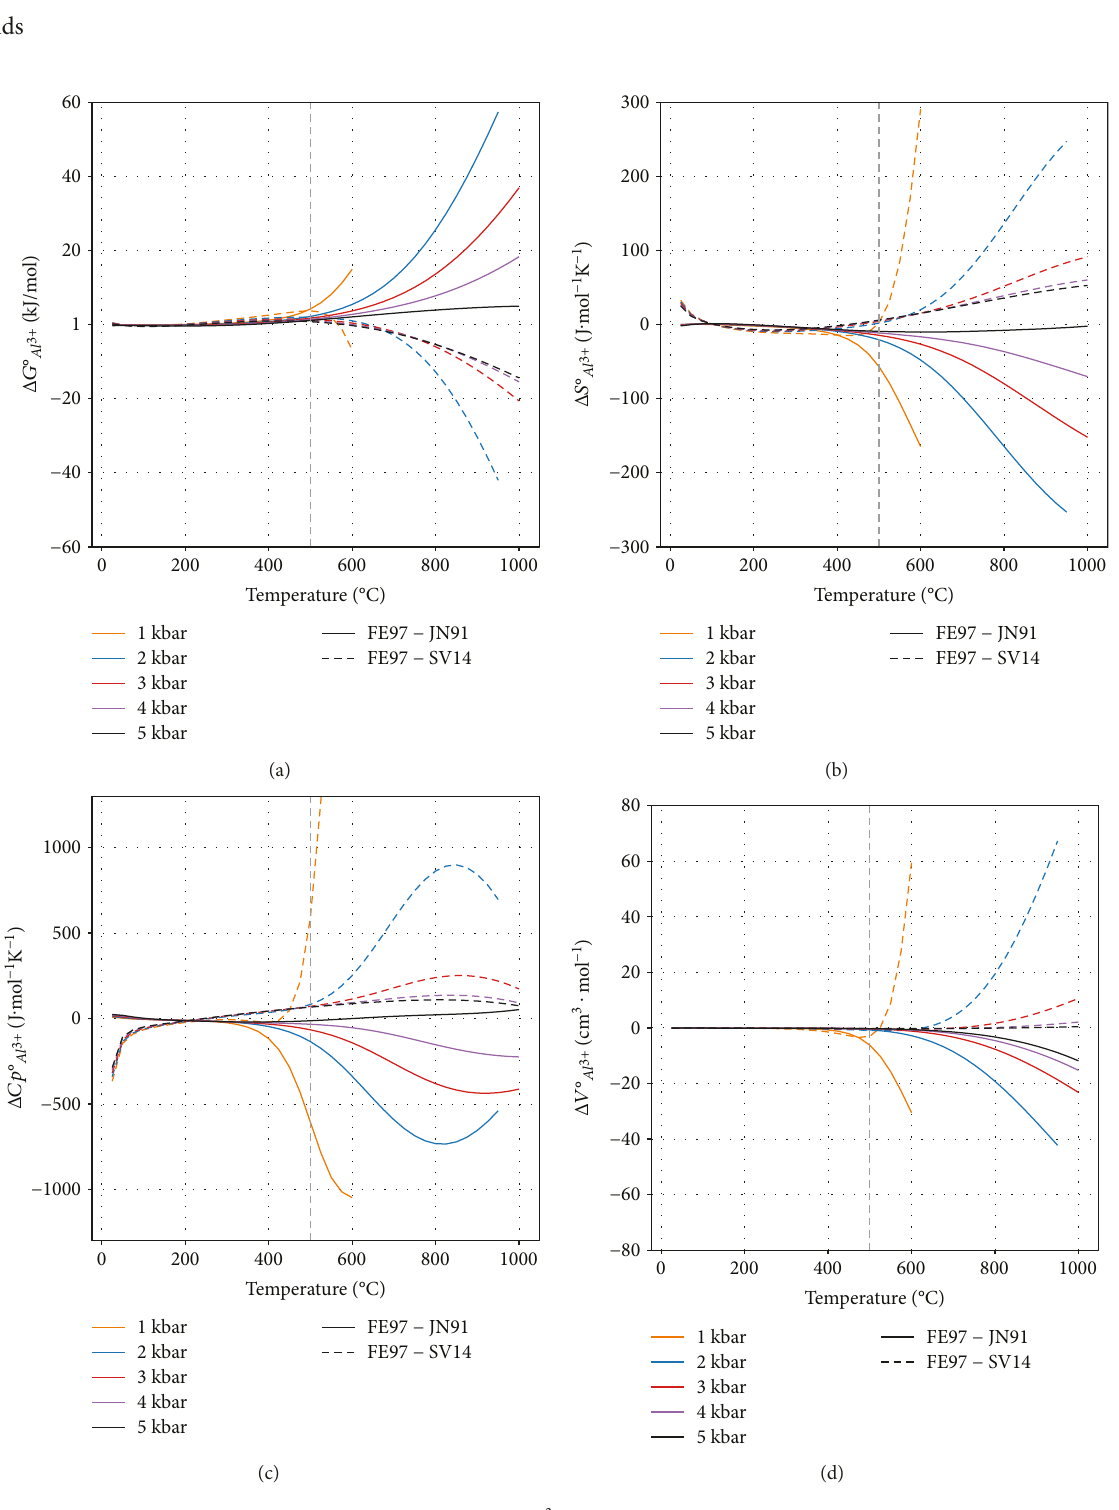
Figure 5: Di ff erences in partial molal standard state properties of Al 3+ , calculated using di ff erent electrostatic models: full lines — di ff erence between FE97 and JN91, and dashed lines — between FE97 and SV14 models for calculating water dielectric properties, all using IAPWS95 for water density: (a) G ∘ , (b) S ∘ , (c) Cp ∘ , and (d) V ∘ . Dashed vertical line intersects at 500 ° Al 3+ Al 3+ Al 3+ Al 3+